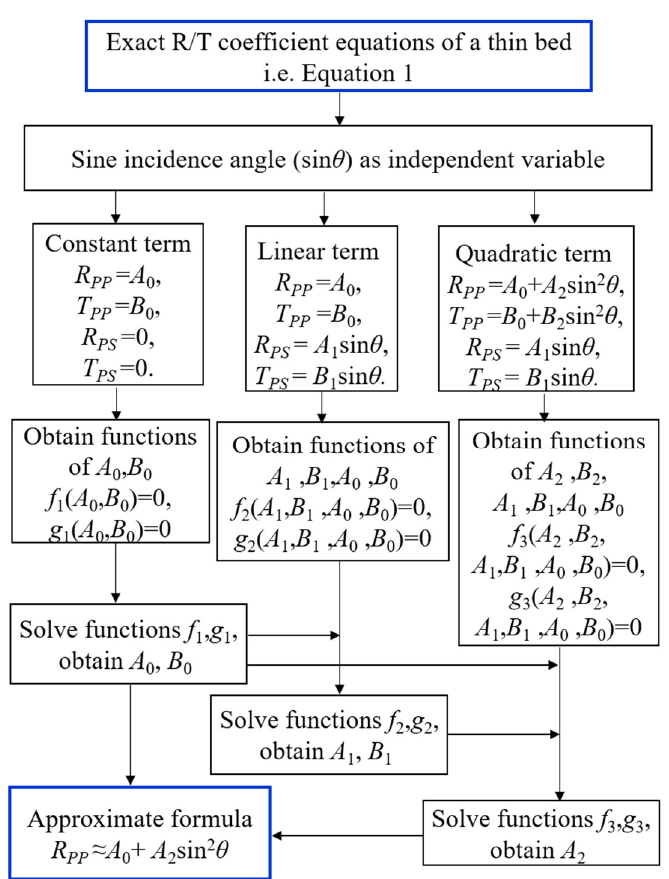
Figure 2. Flowchart of the second-order series approximation simplified from the thin-bed exact R/T coefficient equations.